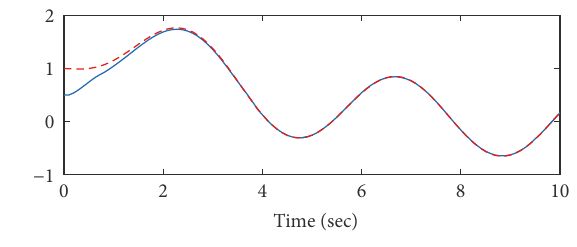
Figure 5: System output: 𝑥 1 (-) and 𝑦 𝑑 (- -).